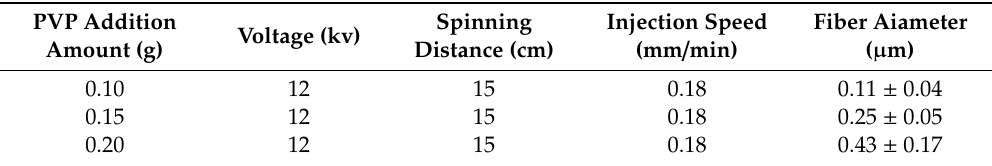
Figure 1. Impact of PVP addition amount on the clearance rate of active molecular membranes ( a : quercetin; b : glycyrrhizic; c : α -mangostin). Table 2. The range of fiber diameter with the different PVP addition amount.